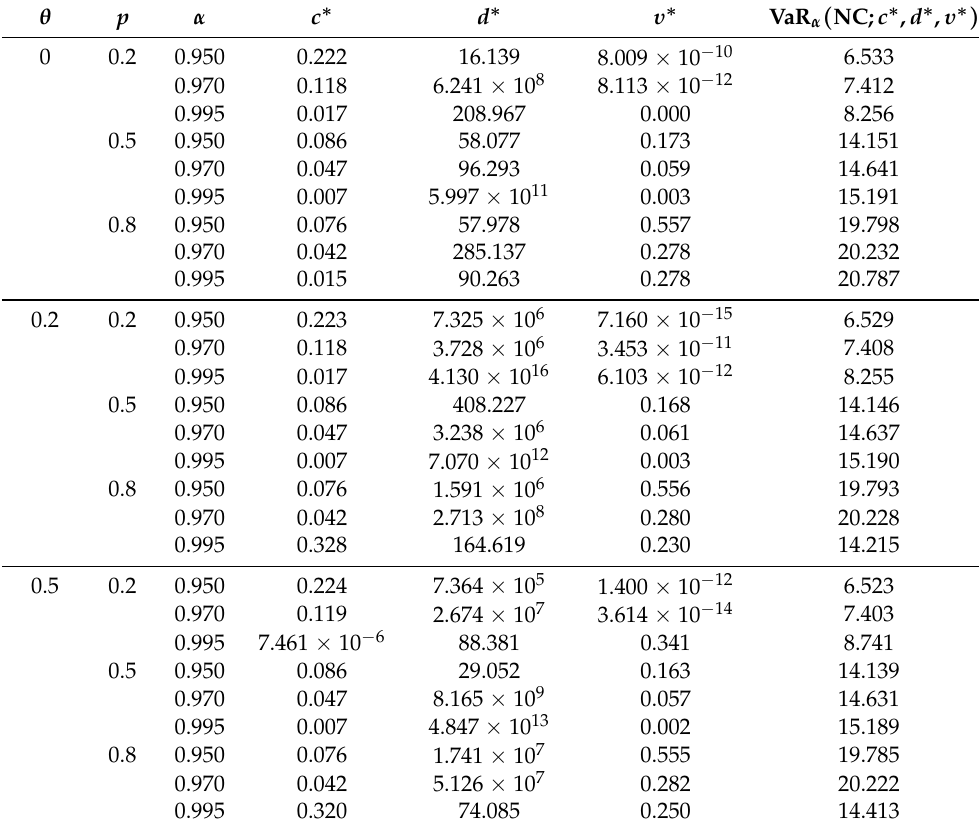
Table 3. Optimal combination of proportional and stop-loss reinsurance and the resulting